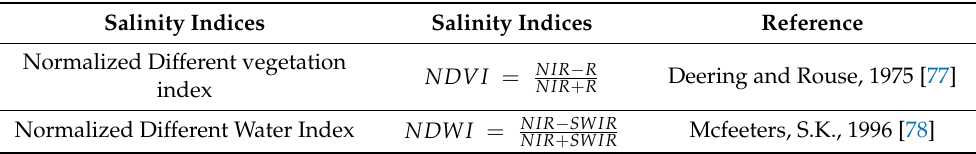
Table 4. Vegetation and water indices as proposed by different authors (where R = Red, NIR = Near- Infrared, SWIR = Shortwave-Infrared, NDVI = Normalized difference vegetation index, and NDWI = Normalized difference water